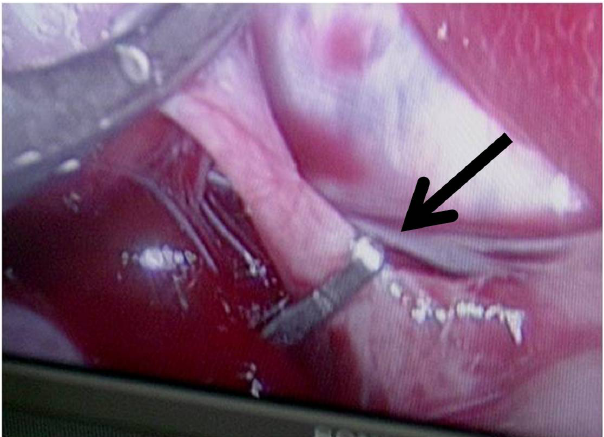
FIGURE 2 - Picture showing the site chosen for the common bile duct ligation aiming biliary obstruction in swine, as well as showing ligation performed with titanium metal clip (arrow)